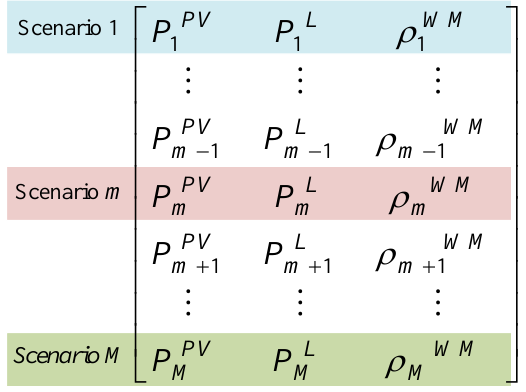
Figure 1. A sample of scenario matrix comprising of M scenarios.